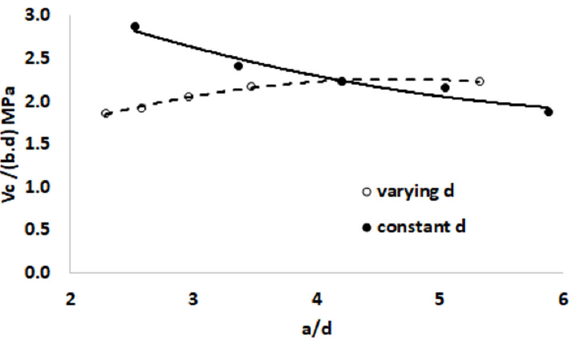
Figure 16. The effect of a/d due to ‘varying d’ and ‘constant d’ on the shear strength of concrete.